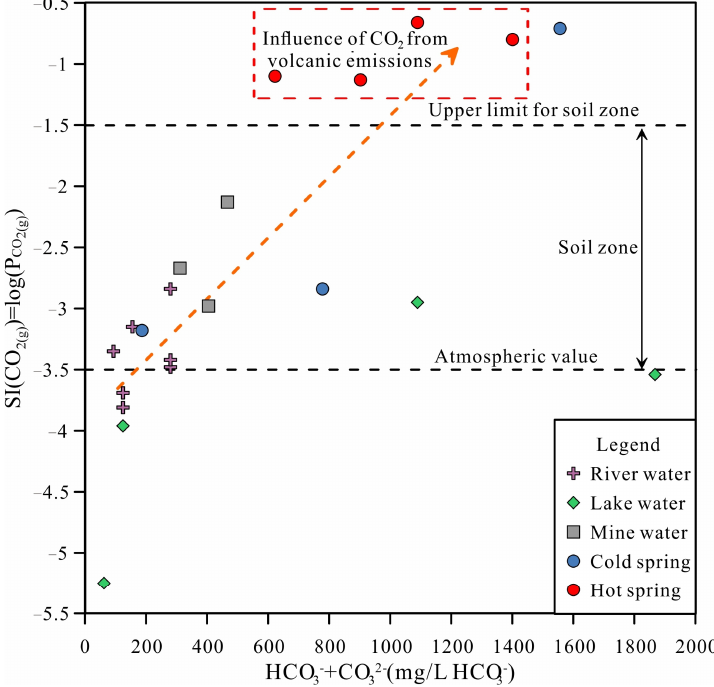
Figure 7. Relationship between HCO 3 − + CO 3 2 − and log (pCO 2 (g)) for the water samples in the study area.